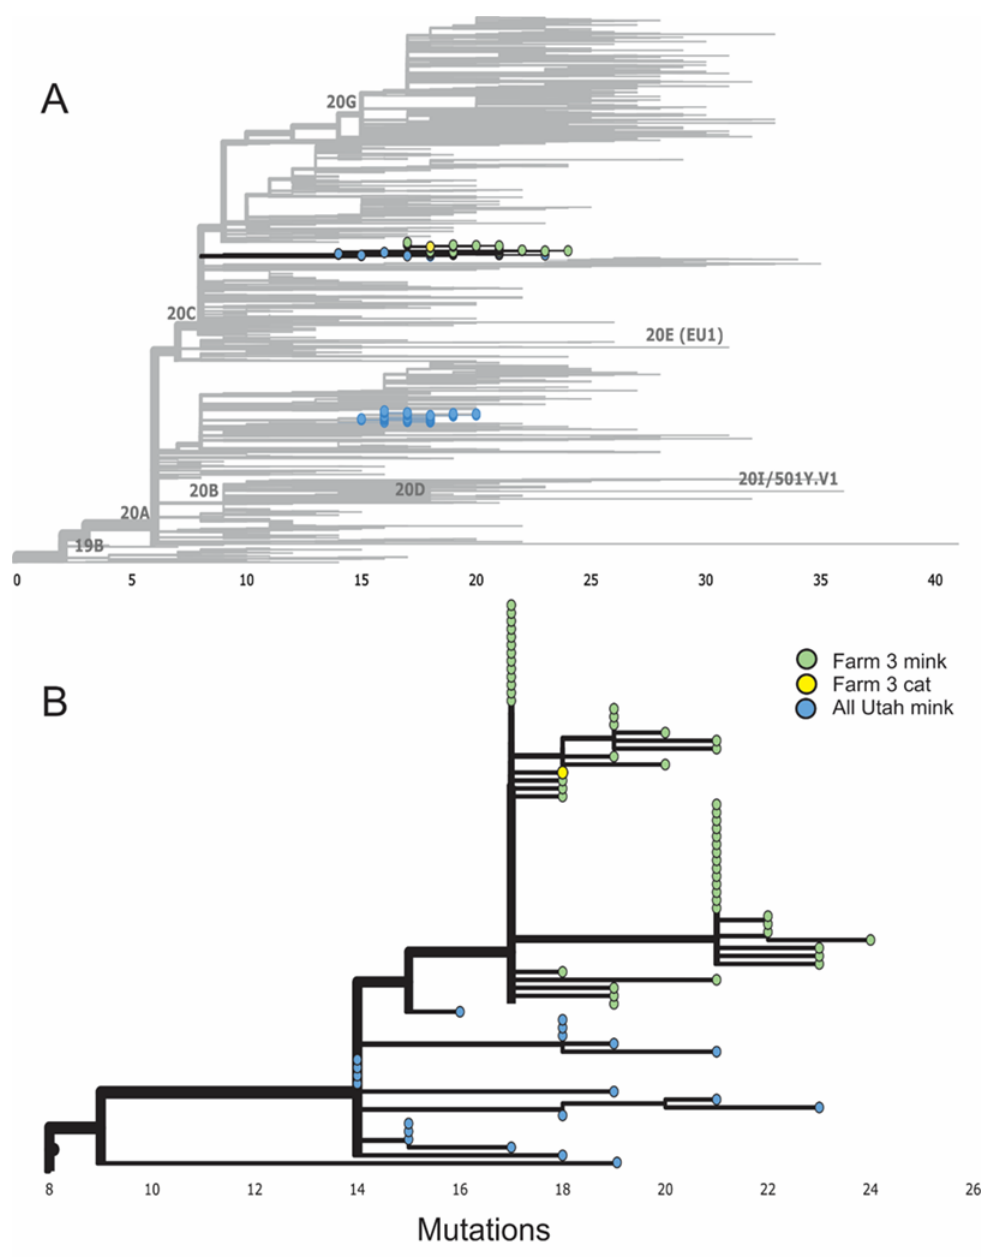
Figure 3. ( A ) Phylogenetic results of a maximum likelihood analysis showing 2822 randomly selected full genome SARS-CoV-2 sequences from mink (n = 120), humans (n = 2701), and one cat from Utah mink farms sampled in August 2020. ( B ) Exploded view of clade 20C containing sequences from Utah mink farms sampled in August 2020, showing nearly identical viral sequences obtained from cat and mink samples on one farm (farm 3).